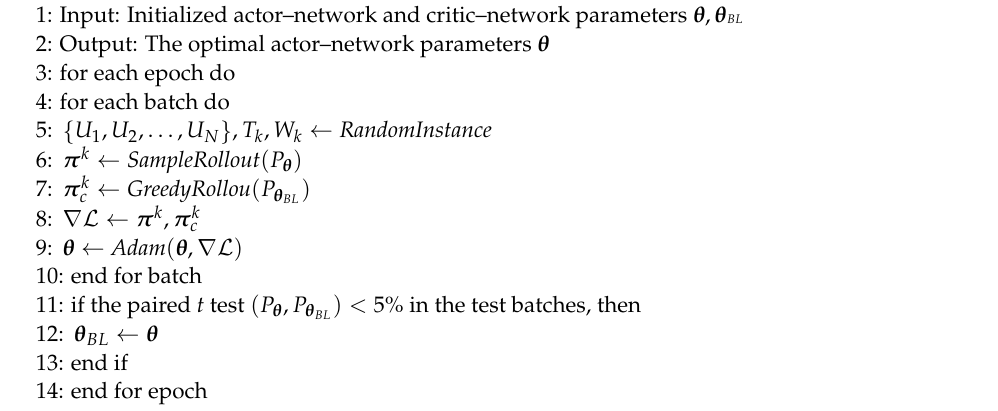
Algorithm 1. Dynamical Information Reinforcement